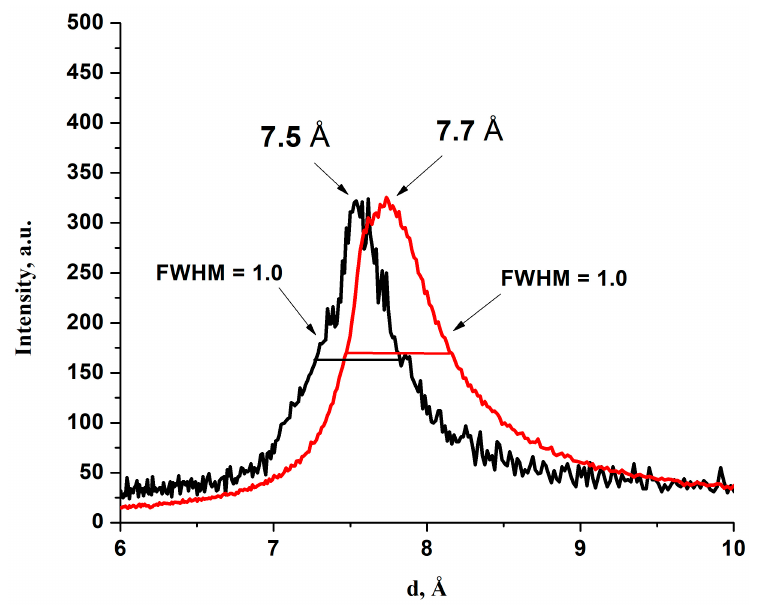
Figure 3. Part of the XRD spectrum of the dry HGO (9:1) powder and the corresponding membrane, prepared by evaporation.